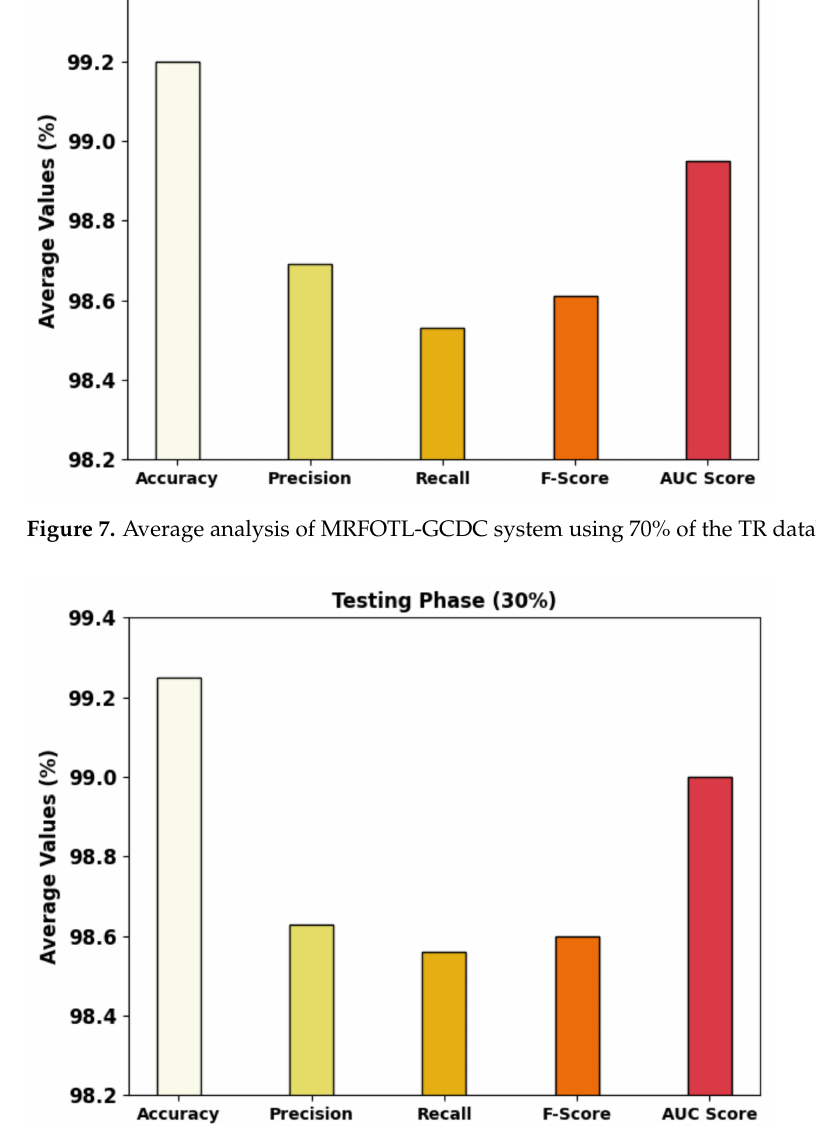
Figure 8. Average analysis of MRFOTL-GCDC system using 30% of the TS